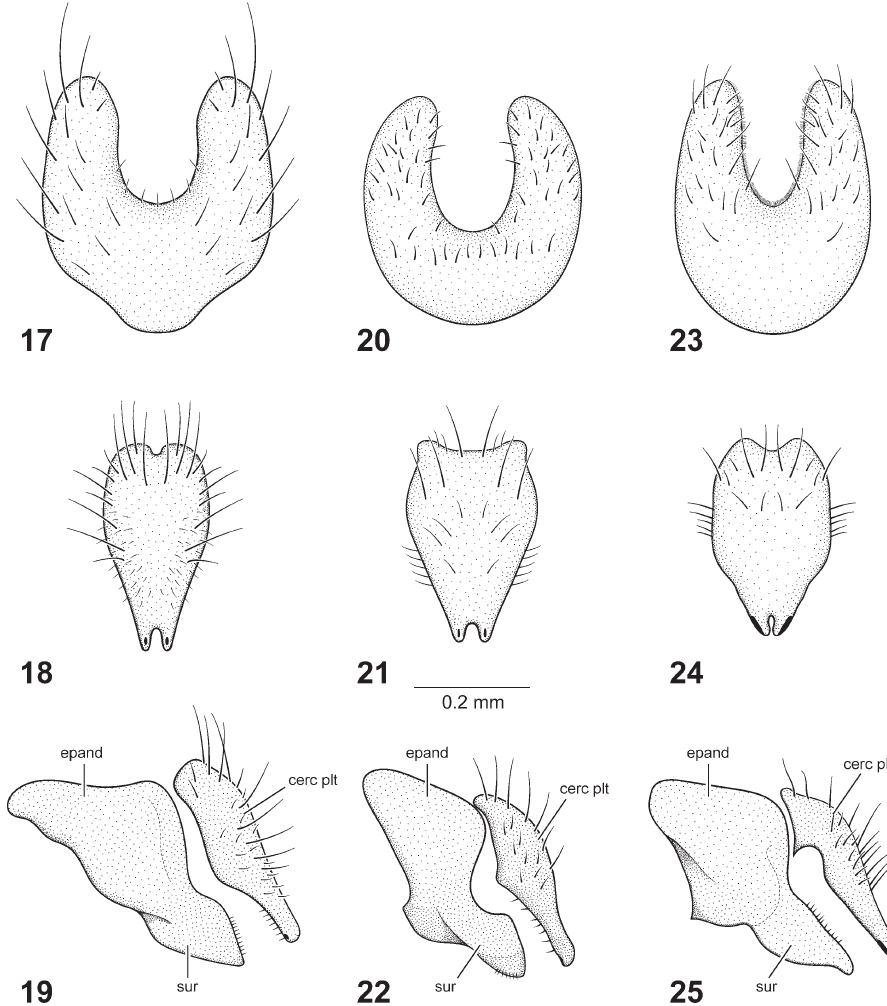
Figures 17–25. Coenosia spp. ♂ , terminalia. C. flagelliseta sp. nov. 17 sternite 5 18 cercal plate, 19 sur- stylus and cercal plate, lateral view. C. macrotriseta 20 sternite 5 21 cercal plate 22 surstylus and cercal plate, lateral view. C. globuliseta 23 sternite 5 24 cercal plate 25 surstylus and cercal plate, lateral view. Figs 20–25 modified (Muller and Miller 2013, figs 6–8). Abbreviations: cerc plt – cercal plate; epand – epandrium; sur –